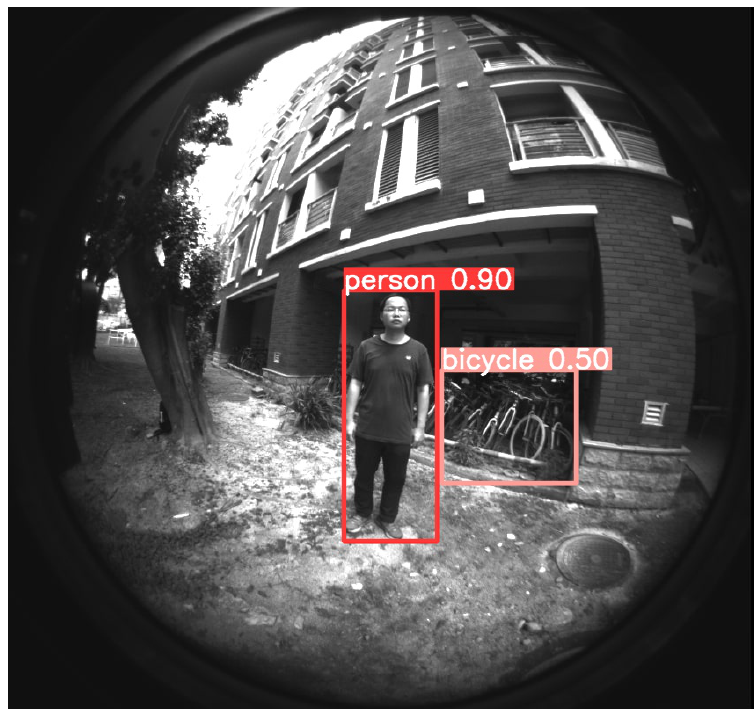
Figure 10. The intelligent person-detection result.